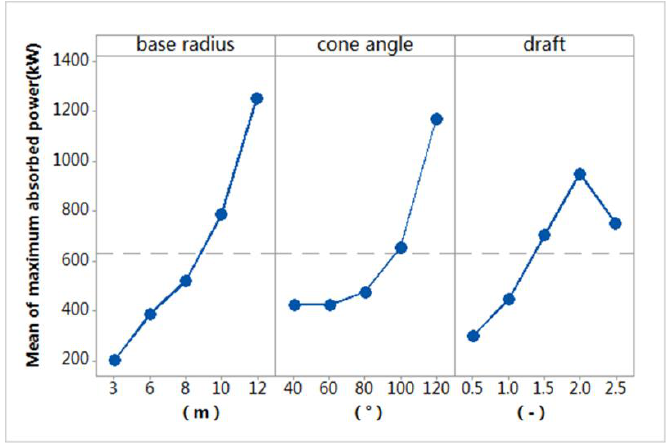
Figure 9. Main effects diagram for maximum absorbed power.